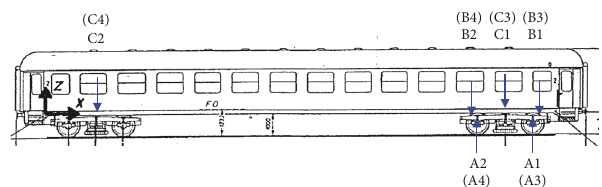
Figure 2: Measurement points of the test train (passenger car), axle boxes A1 and A2, bogie points B1 and B2, and carriage points C1 and C2, on the right hand side; A3, A4, B3, B4, C3, and C4 are located symmetrically on the left hand